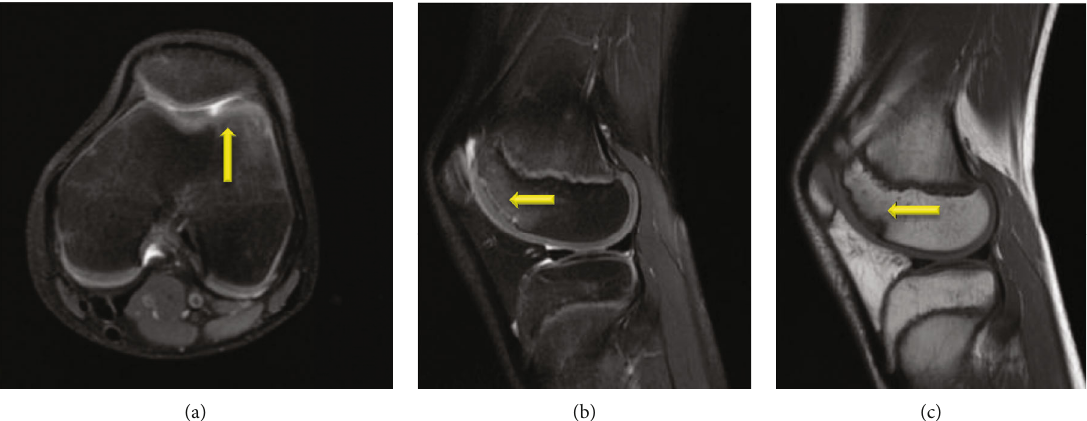
Figure 2: MRI evaluation of the knee showing stable trochlear osteochondritis dissecans (OCD) lesion on the (a) axial T2-weighted image,